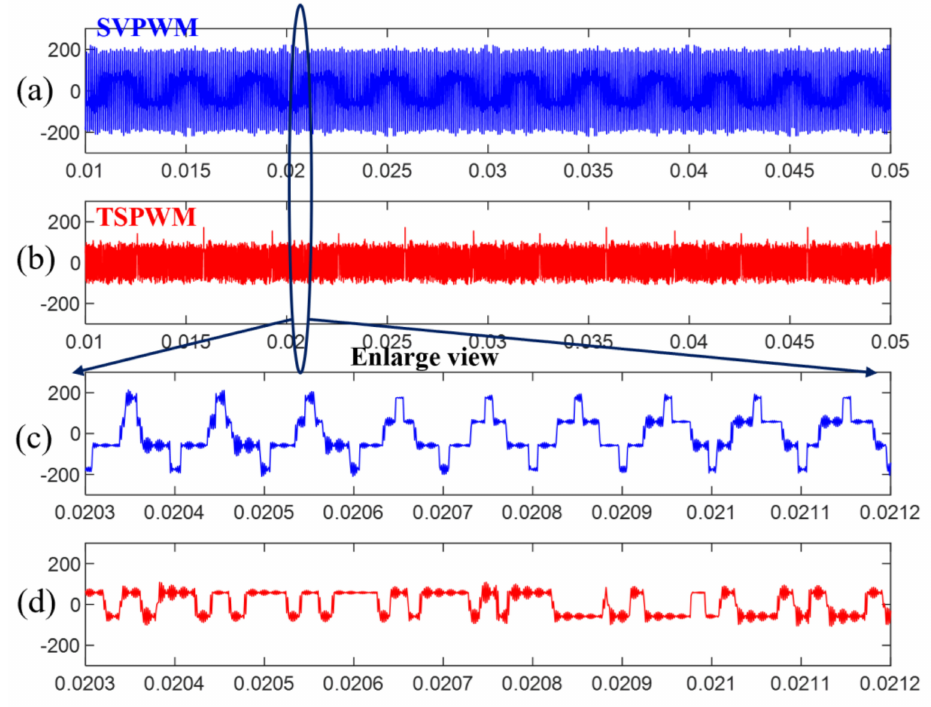
Figure 11. Comparison of common voltages with SVPWM and TSPWM in high modulation region (M = 0.8): ( a ) SVPWM; ( b ) TSPWM; ( c , d ) are the enlarge views of ( a , b ),